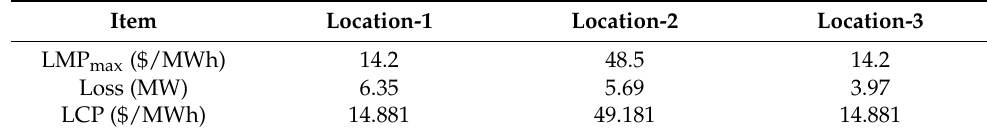
Table 5. Analysis Result of LMP, Losses, and Customer Price.